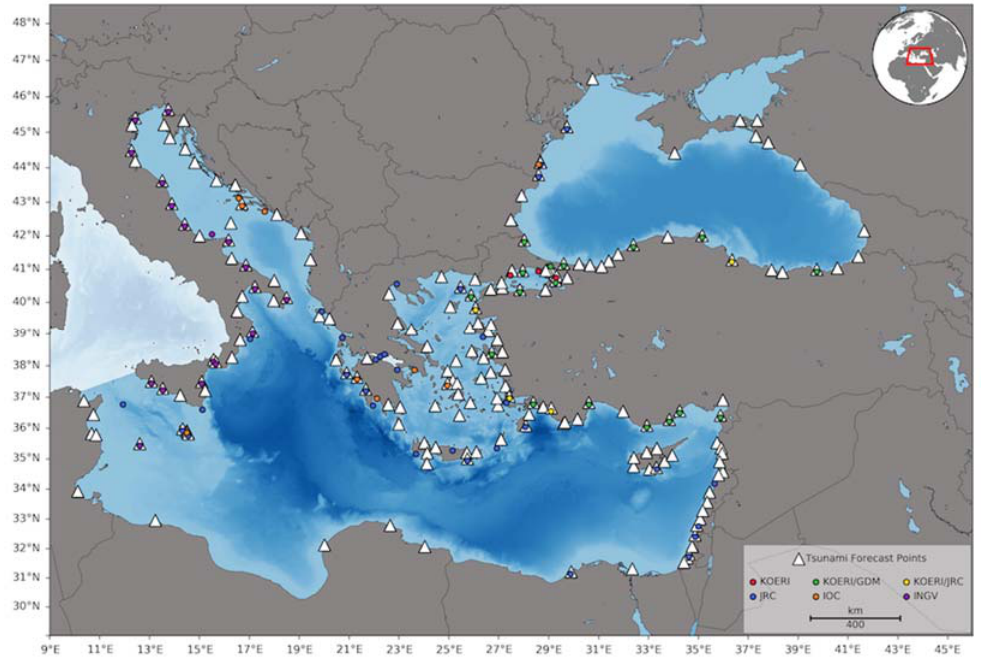
Figure 1. KOERI–TSP service area (which excludes the Western Mediterranean and Corinth Gulf), tsunami forecast points (TFPs—shown as white triangles) included in its messages and tide gauges (shown as colored dots) available to KOERI-RETMC in its TSP operations.